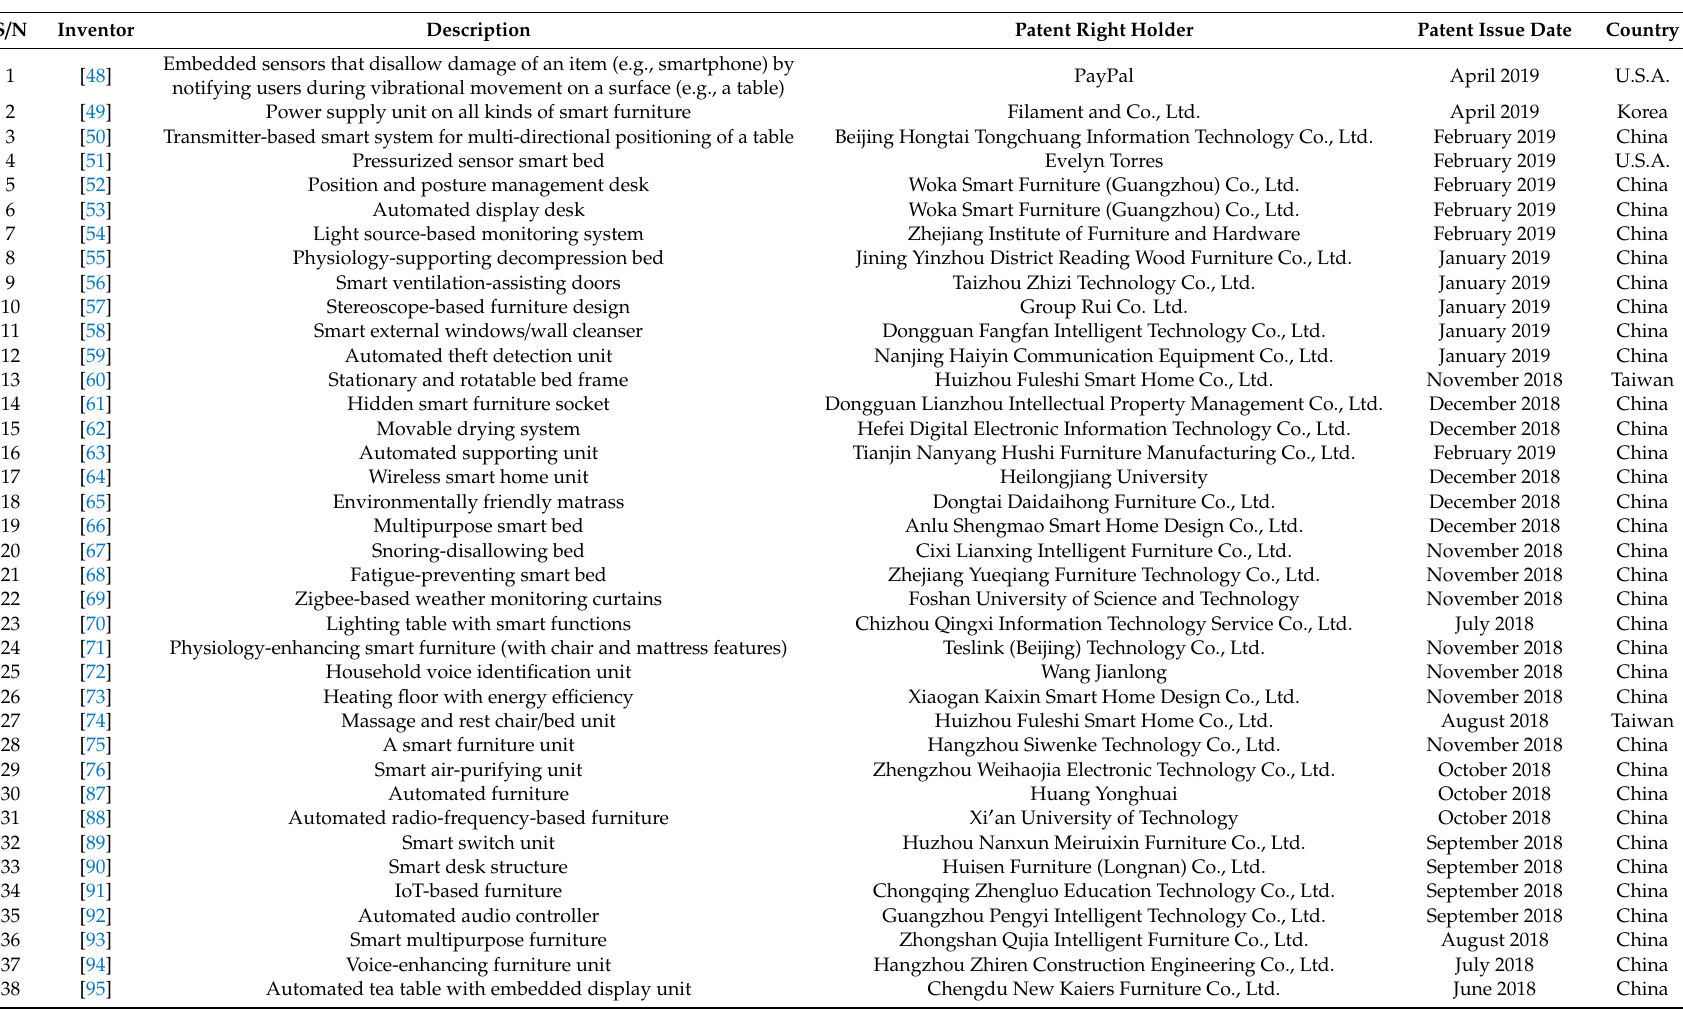
Table 6. Summary of selected Smart Furniture